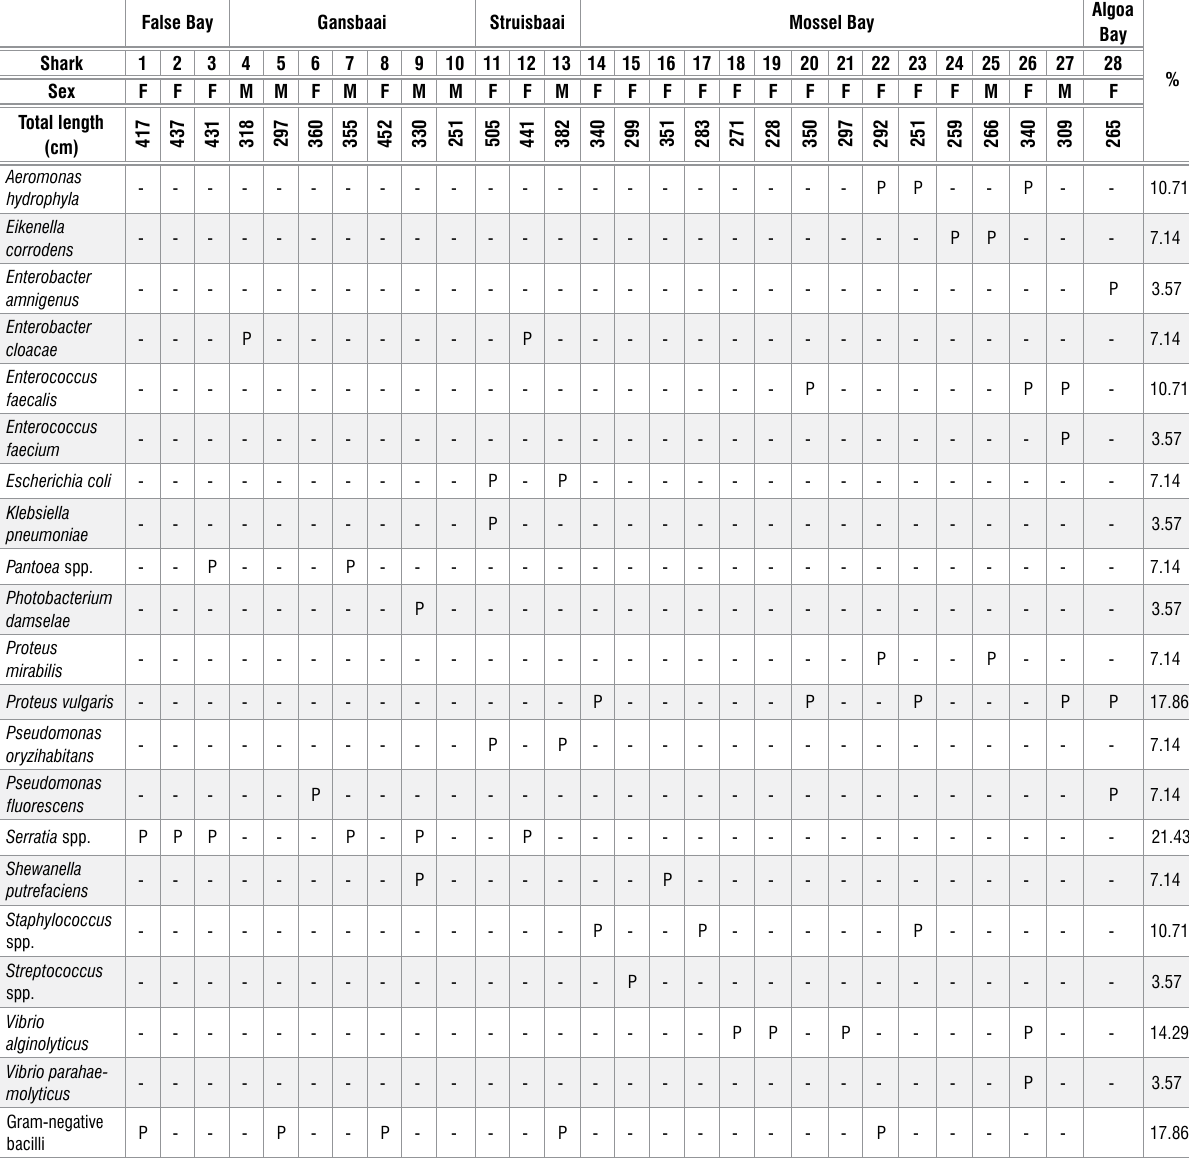
Bacterial species identified from swab samples taken from the oral cavities of 28 live white sharks ( Carcharodon carcharias ) False Bay Gansbaai Struisbaai Mossel Bay